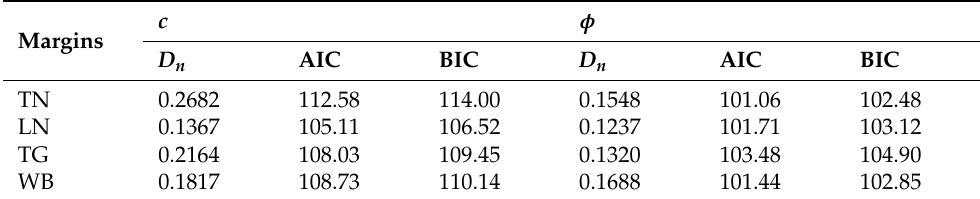
Table 10. Goodness-of-fit test results of different margins.